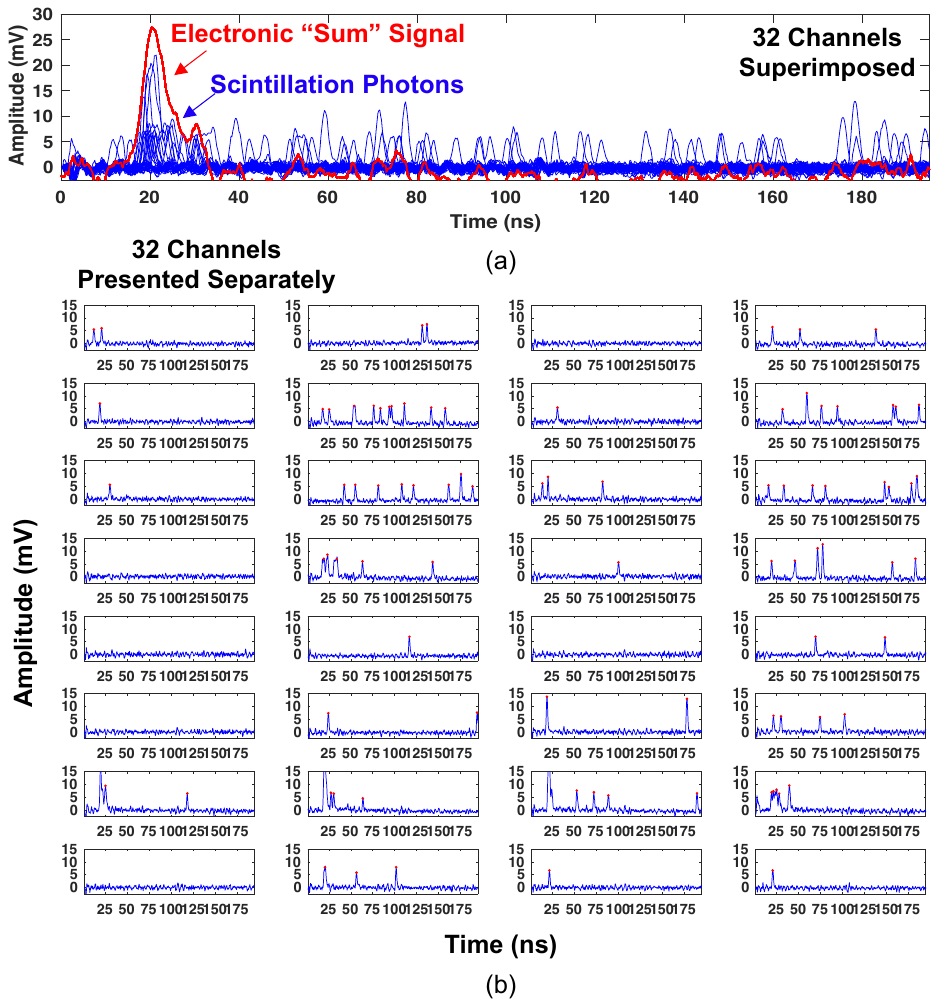
Figure 9. An example of spatiotemporal photon distribution of optical photons arriving at the sensors in the small prototype detector readout is shown in blue in ( a ), along with the “sum trigger” in red. The same data, separated into each electronic channel, is shown in ( b ), along with red dots that indicate the peak location of